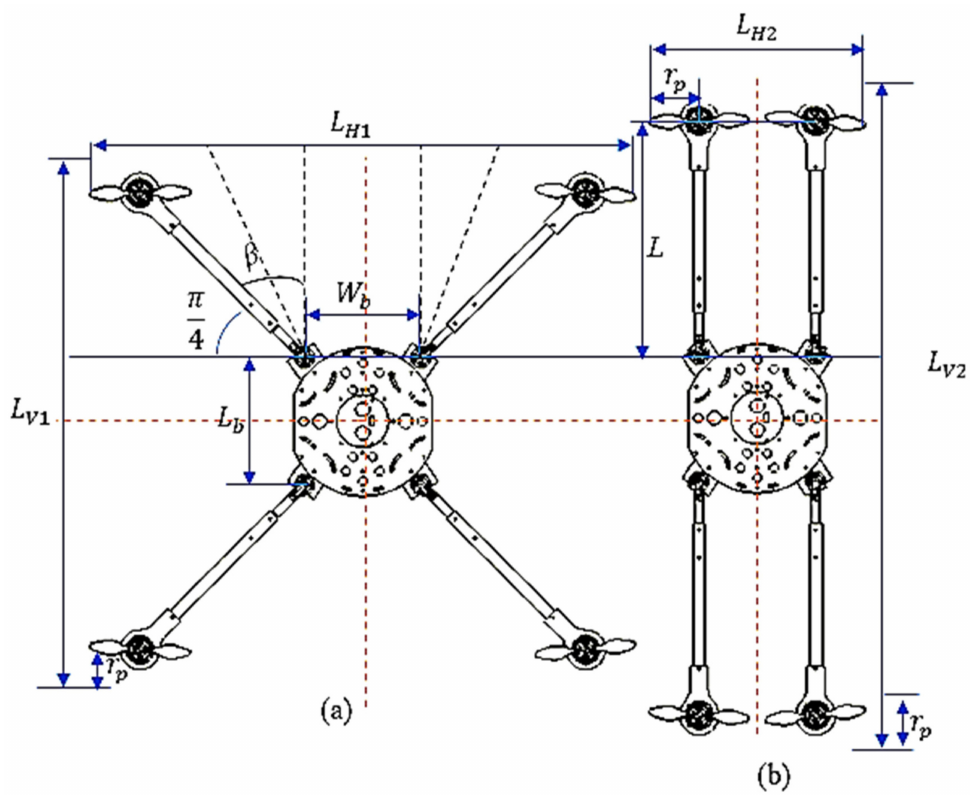
Figure 3. Geometry of the morphed MUAV: ( a ) unfolded MUAV in “X” Configuration ( b ) folded MUAV in “H” Configuration. L H denotes the horizontal distance between the two arms, including the radius of the two propellers “ rp ”. When the arm is driven to realize a compact structure the L H value will vary from L H 1 to L H 2 as it was depicted in Figure 3. Where L H 1 is the maximum unfolded horizontal space between the arms and L H 2 is the minimum folded